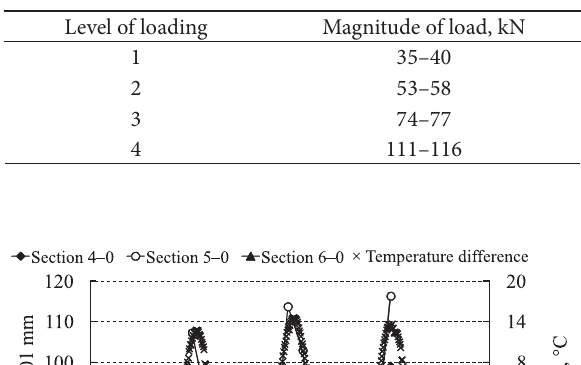
Table 2. Applied FWD loading